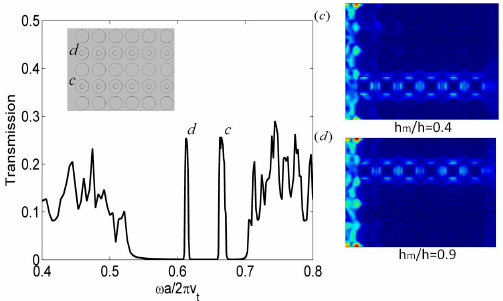
Figure 12. The multichannel wavelength multiplexer. ( Left panel ): Transmission spectrum of the antisymmetric Lamb wave when the filled mercury heights inside waveguide c and d are h mc /h = 0.4 and h md /h = 0.9; ( Right panel ): Displacement field distributions at the frequency of the two narrow pass bands c and d . The geometric parameters of the multiplexer are h/a = 0.45, r/a = 0.4, l/a = 0.2, r i /a = 0.11.